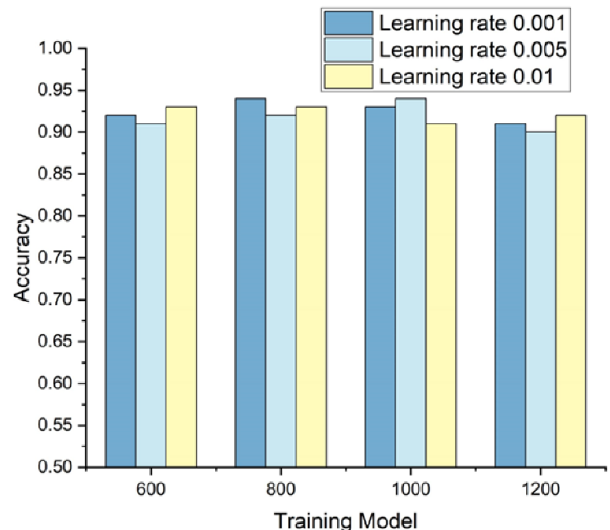
Figure 11. Effect of learning rate on accuracy